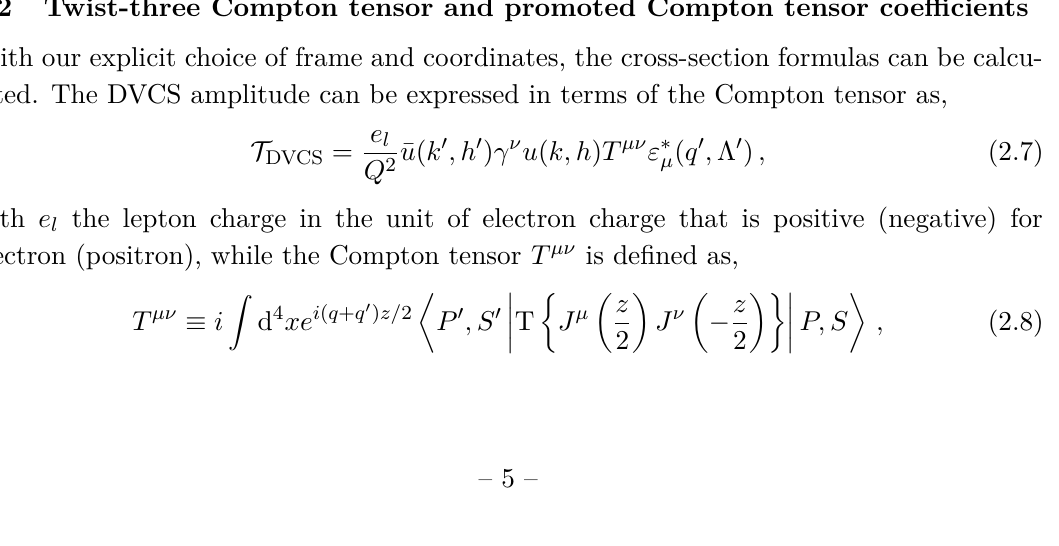
Figure 2 . The coordinate choice in transverse x - y plane with the z -axis pointing outwards for fixed-target experiments (left) and the collider experiments (right). The transverse momenta in the fixed-target coordinates satisfy ~q 0 the collider coordinates are not align with each other though the momentum conservation ensures + ~k 0 + ~P 0 = 0 ~q 0 ⊥ ⊥ ⊥